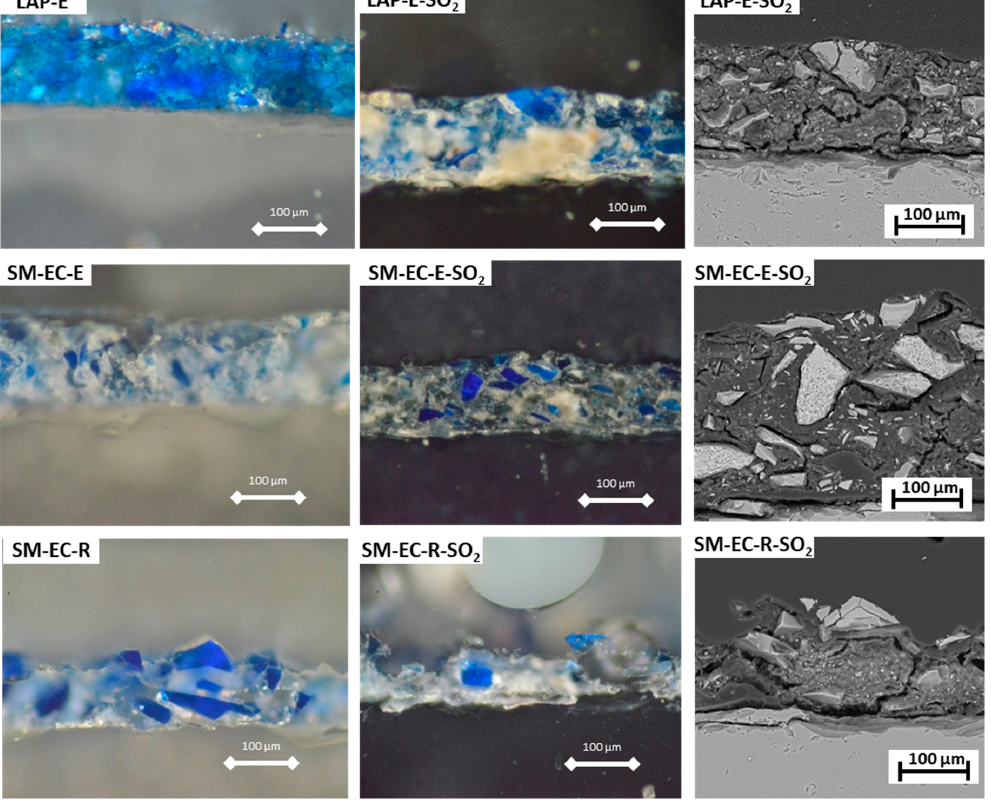
Figure 6. Micrographs taken with polarized light microscope (PLM) (left and center) and SEM (right) of cross-sections of selected tempera paint mock-ups made with lapis lazuli (LAP) or smalt (SM) mixed with either egg yolk (E) or rabbit glue (R) before and after SO 2 exposure. Center and right columns showed micrographs of the same part of the tempera mock-ups. Check Table 1 to better follow the paints labeling. –SO 2 shows the aged samples.